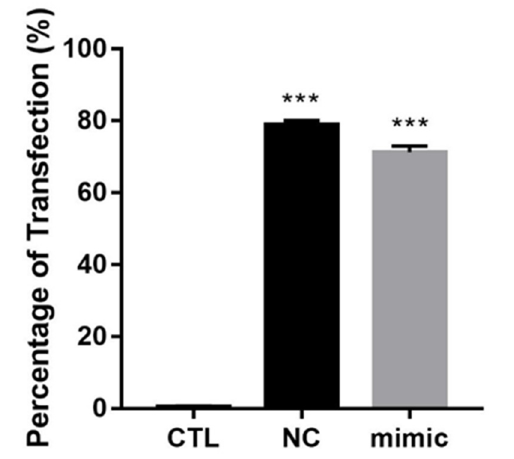
Figure 2. Transfection efficiency of miR-126 mimic in MCF-7. Percentage of transfection in FAM- labeled NC and miR-126 mimic–transfected cells as compared to untransfected control (CTL). Error bars represent SEM ( n = 3). *** denotes p < 0.001.